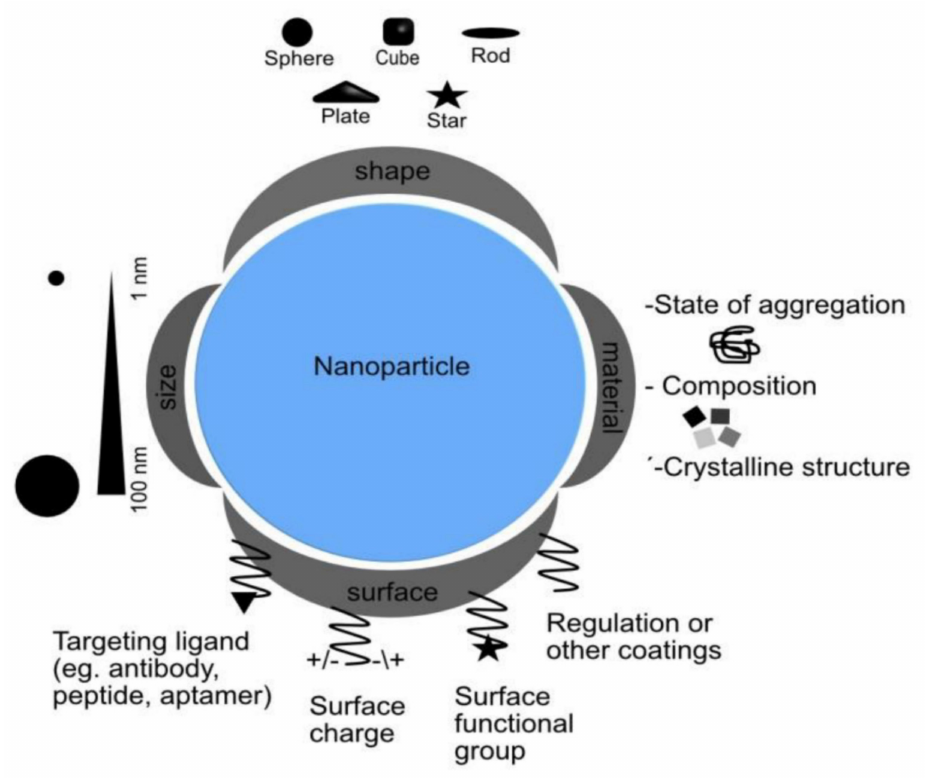
Figure 3. Different physiochemical properties of nanoparticles